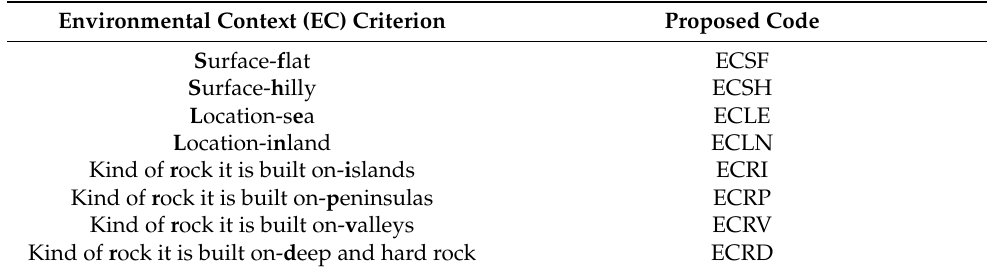
Table 2. Environmental context criteria according to ISO 37120 [11] to be used in the DT-DNA model of smart